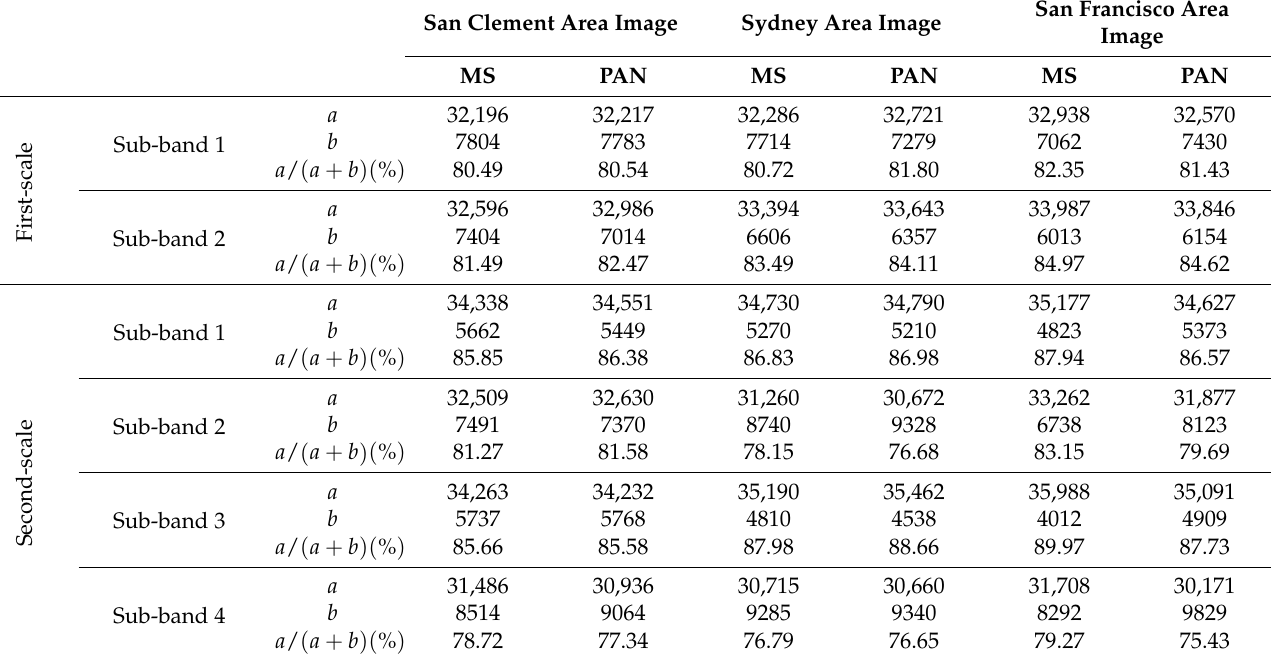
Table 1. Statistical results of directional neighborhood correlation and eight neighborhoods correlation of the high frequency